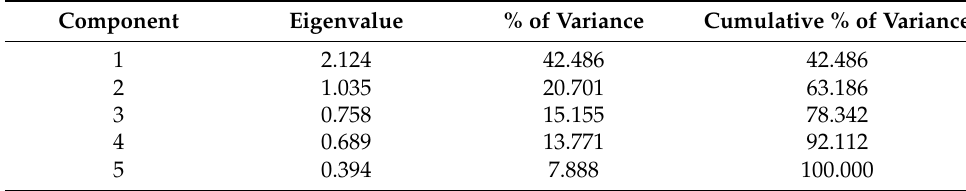
Table 4. Explained variance in the five components.